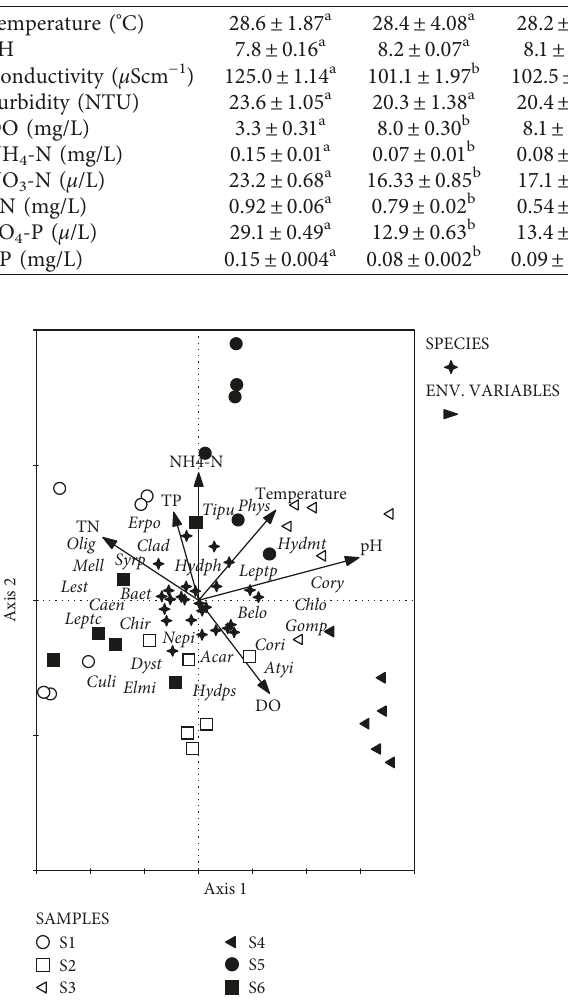
Table 2: Mean ( ± SE) of physicochemical parameters measured at six sites in Sanyati basin (Lake Kariba) for the period January-March 2018. Parameters